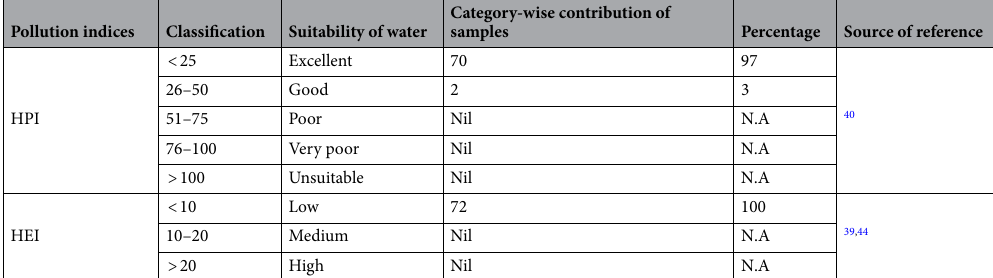
Pollution indices